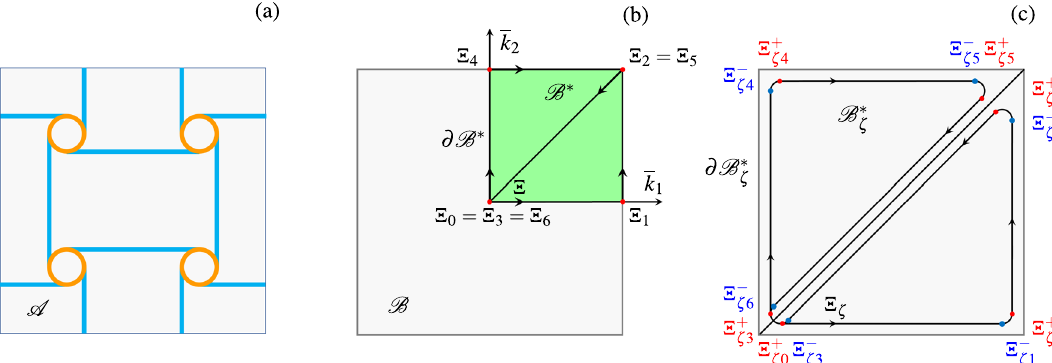
Figure 2. ( a ) Periodic cell A of the anti-tetrachiral beam-lattice model; ( b ) dimensionless first Brillouin zone B , first irriducible Brillouin zone B ⋆ and bi-triangular path ∂ B ⋆ ; ( c ) perturbed bi-triangular path, with rounded corners ∂ B ⋆ ζ corresponding to the domain B ⋆ ζ , parametrized by the perturbation parameter ζ > 0